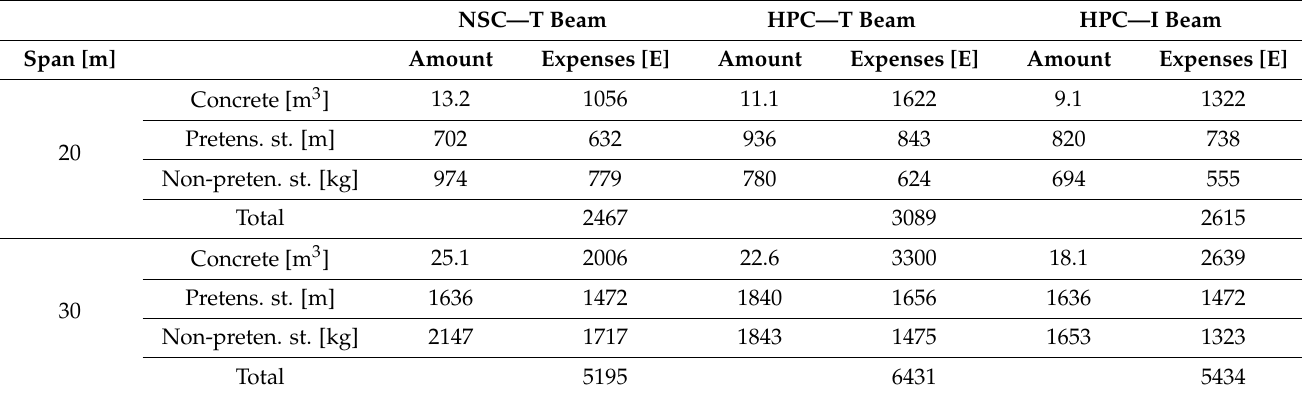
Figure 14. Cross-section of bridge beams with layout of pretensioned reinforcement, bridge span 30. Table 9. Tentative expenses for parametrical bridge